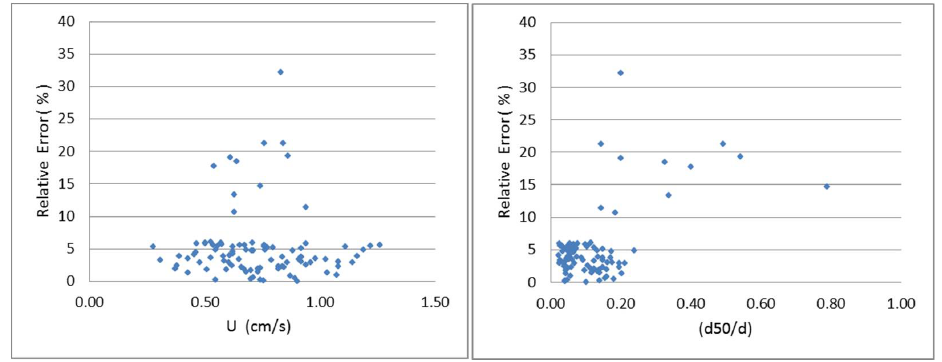
Figure 12. Relative error of skin friction factors calculated using Equation (24) and the BLCM method in comparison with average velocity ( left ) and relative roughness ( right ).